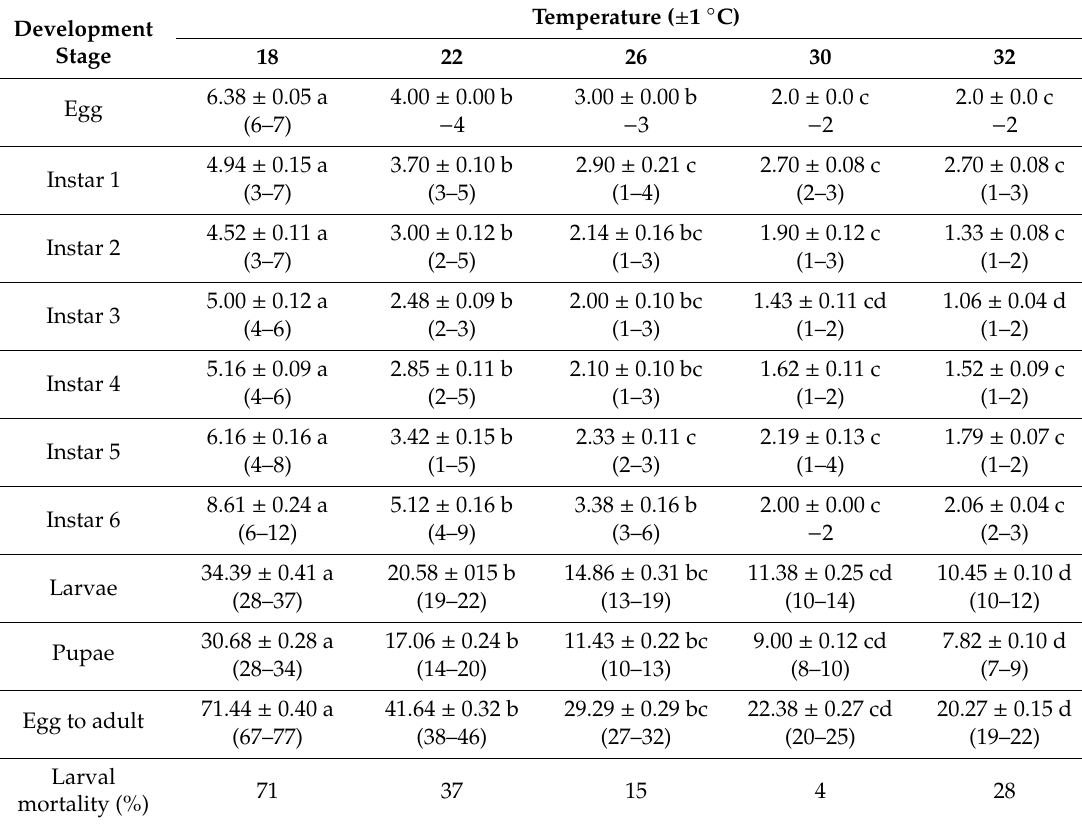
Table 1. The mean development time (days ± S.E.) of di ff erent life stages and larval mortality of Spodoptera frugiperda at constant temperatures. The range or number of days taken to complete a stage is shown in